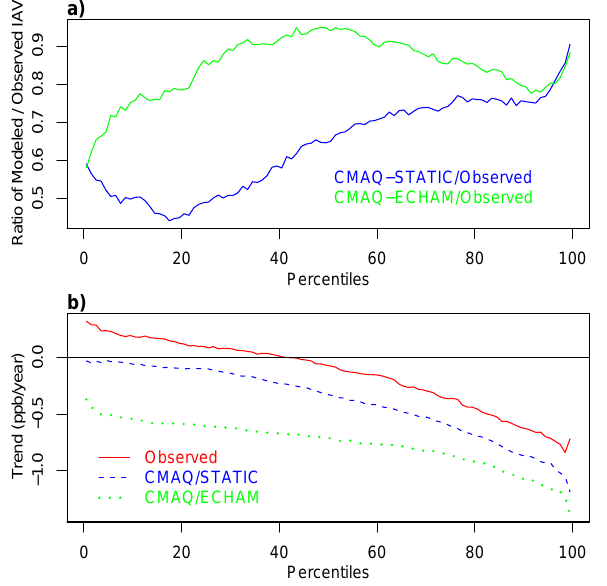
Fig. 10. (a) Ratio of modeled to observed IAV vs. percentiles of May–September 8-h daily maximum ozone concentrations for both CMAQ/STATIC and CMAQ/ECHAM5-MOZART; the median IAV ratio across all 90 sites is shown for each percentile. (b) Ob- served, CMAQ/STATIC, and CMAQ/ECHAM5-MOZART least- squares trend estimates for 1988–2005 (y-axis) vs. percentiles of the May–September 8-h daily maximum ozone distribution. Trends were calculated separately at each of the 90 monitoring sites, the median trend across all sites is shown here.